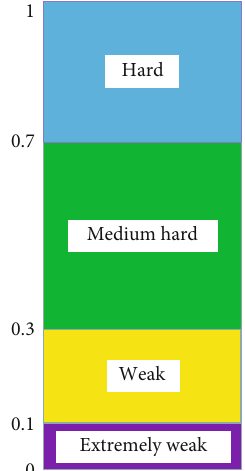
Figure 1: Classi fi cation of rock stability based on ratio coe ffi cient of hard rock